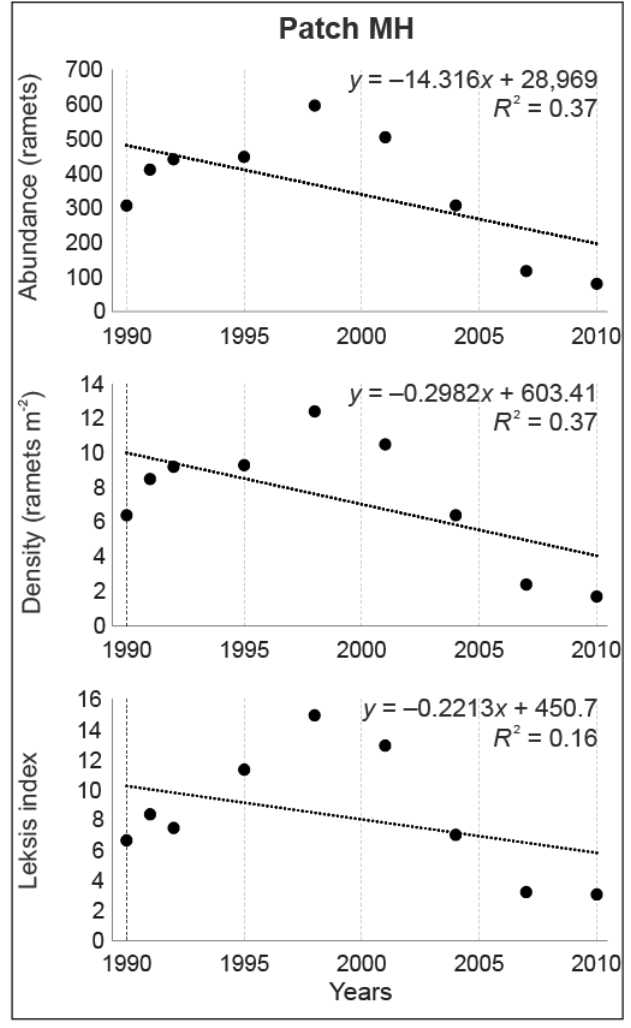
Figure 6 Changes of values and linear regression for abundance, density, and Leksis’ index of the Senecio umbrosus population within patch